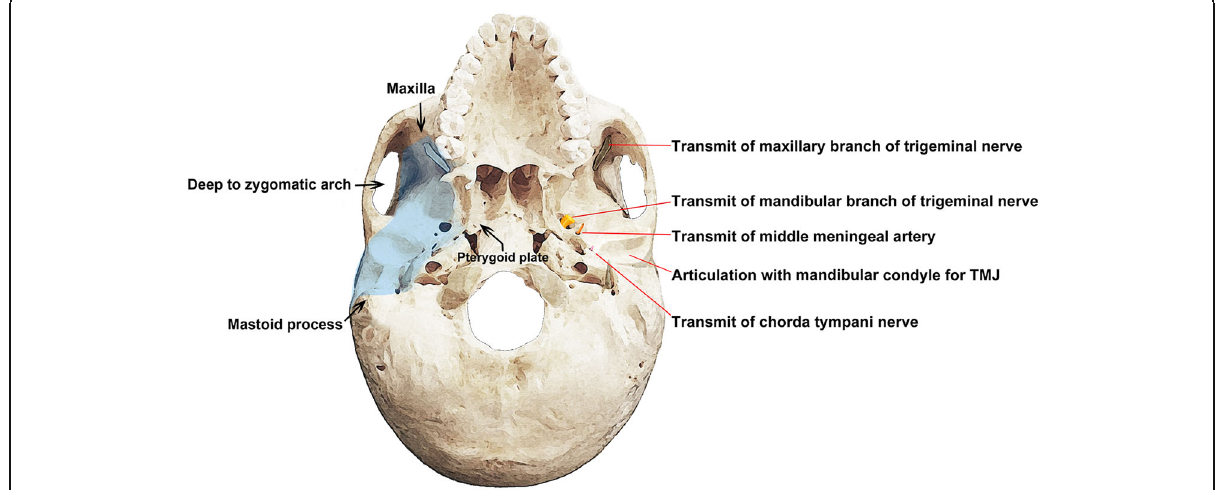
Fig. 2 Lateral skull base showing the boundary (left) and contents of the infratemporal fossa